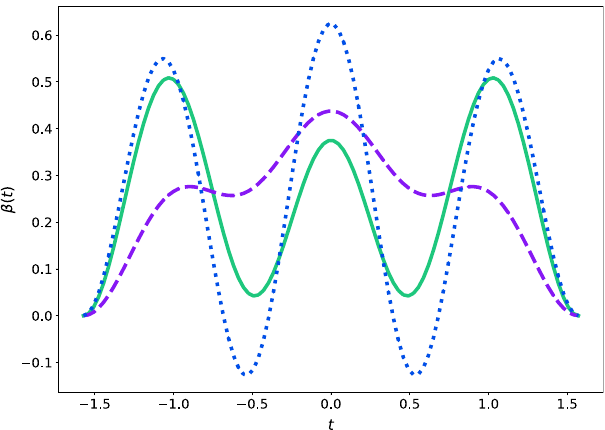
Figure 3. Temporal profile of three polyharmonic pulses β( t ) in the symmetric interval 7 9 , c 2, c 3 (solid line), b b 5 2 (dashed), and b = = − = = = − endpoints of the interval, even though only the amplitudes in solid and dashed curves can be utilised to achieve squeezing transformations of the form (Eq. 20), since β( t ) > 0 in both cases, whereas the field amplitude depicted with a dotted curve could generate an evolution loop effect over the canonical variables—useful for ion traps, for instance—in that the matrix h ( t ) will fulfil the condition